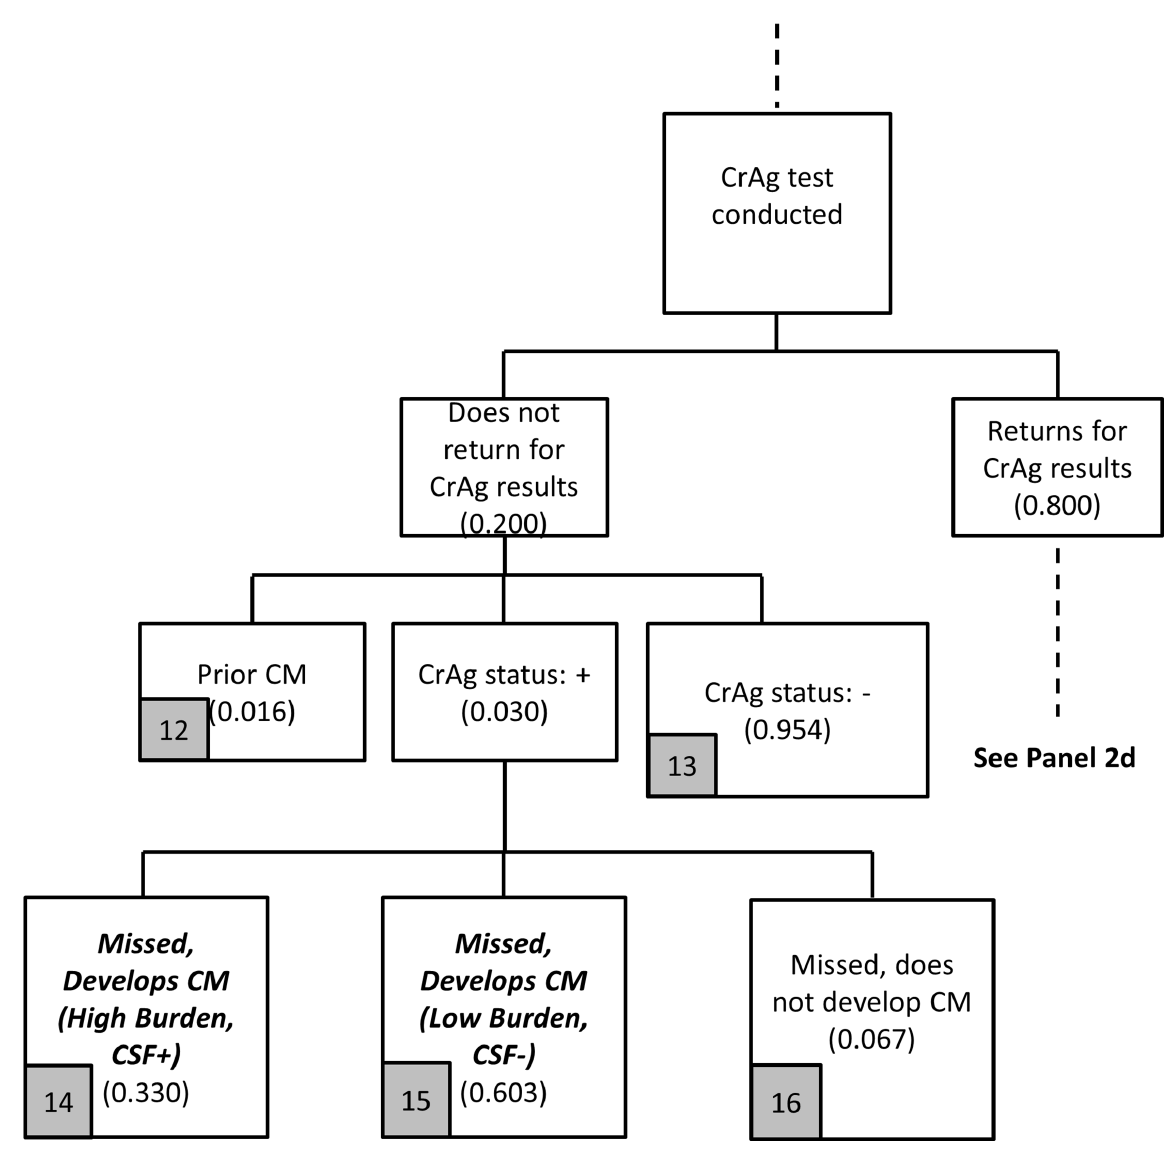
Fig 6. Provider-initiated screening flowchart (Panel